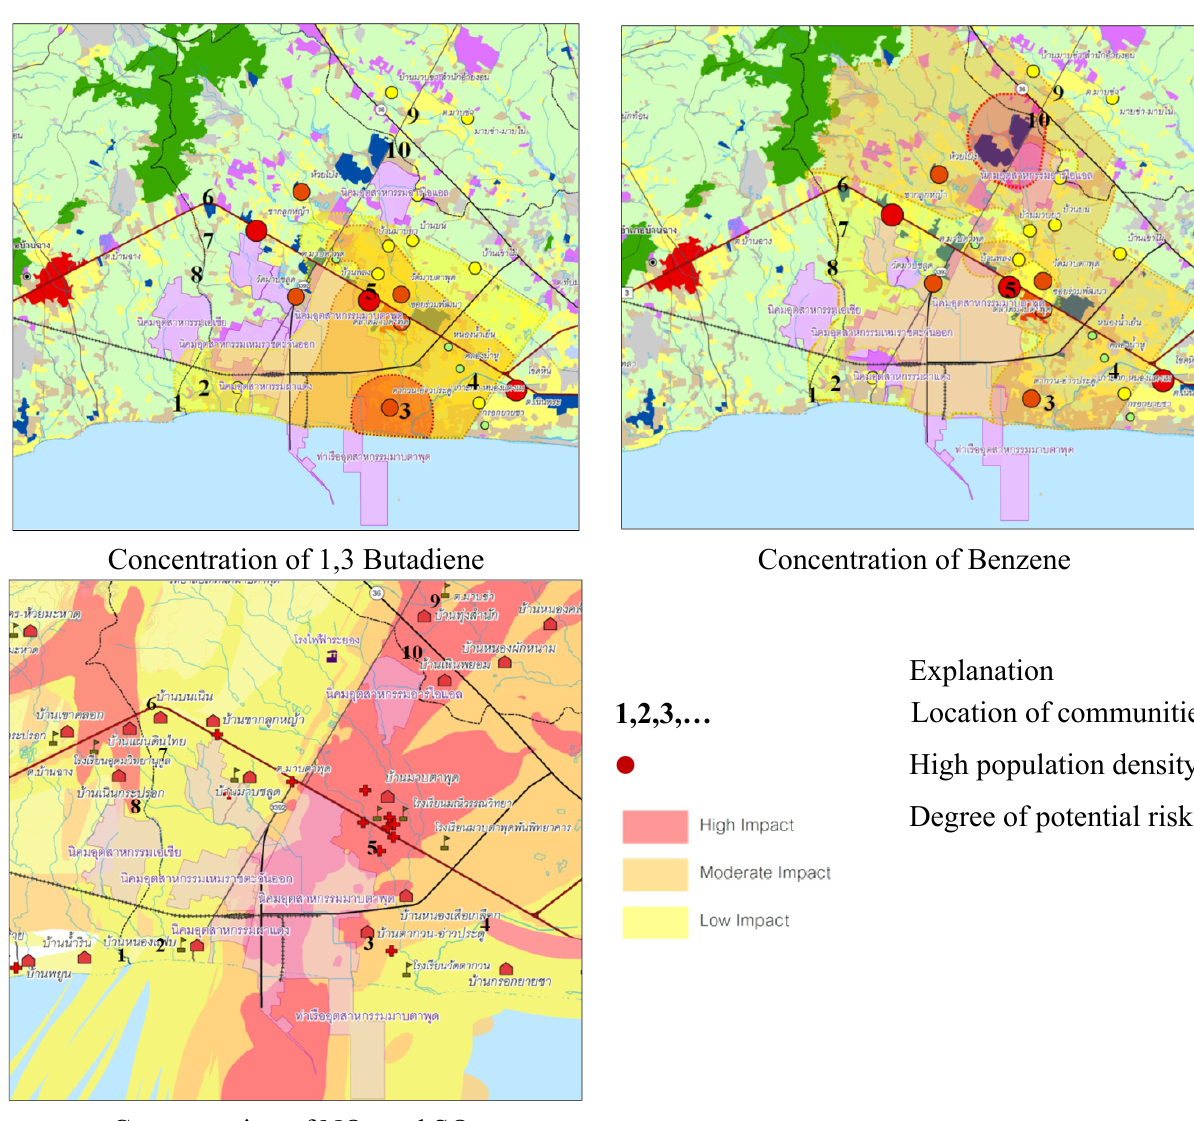
Figure 2. Distribution of hazardous gases and compounds throughout the Maptaphut area.